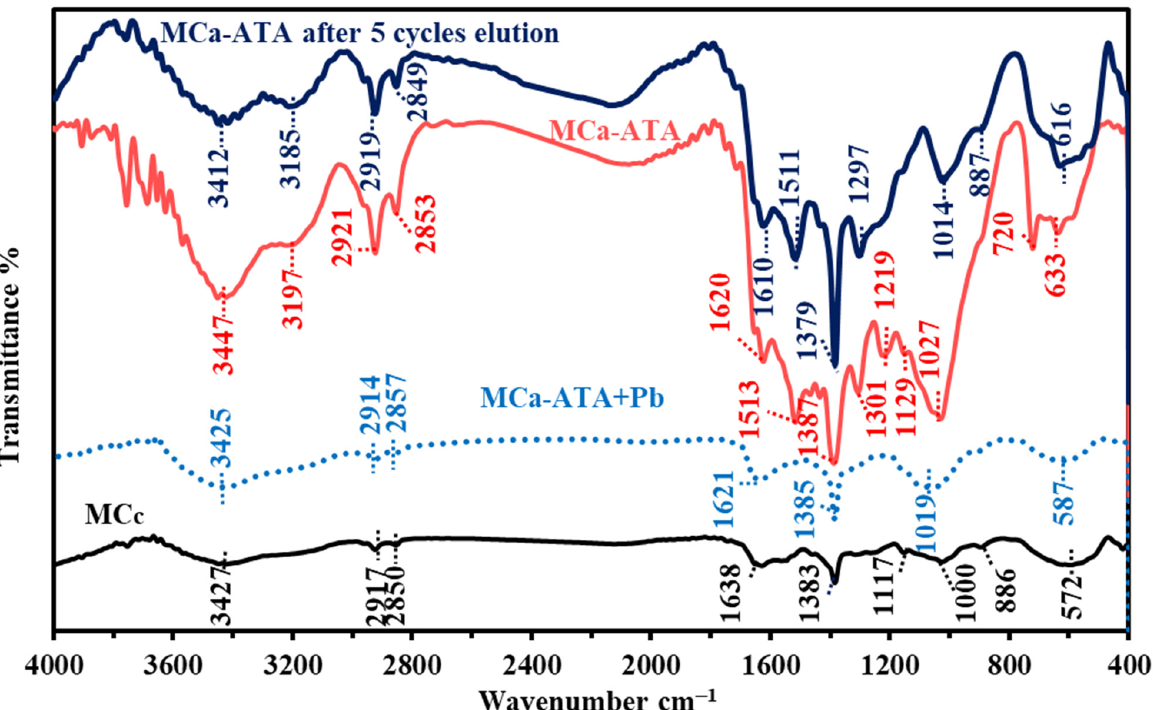
Figure 3. FTIR spectra of the MCc and MCa-ATA after sorption and after five cycles of sorption desorption . Table 1. Assignments of FTIR peaks for MCc and MCa-ATA before and after sorption and after five cycles of sorption desorption for Pb(II) .